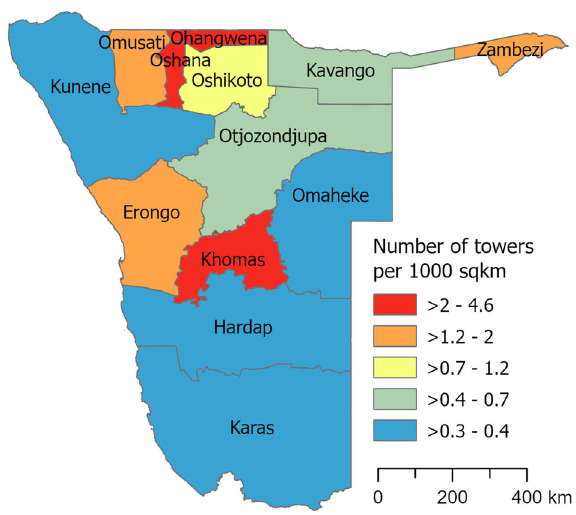
Fig. 2 Cell tower density in Namibia at administrative level 1 (regions; GADM,